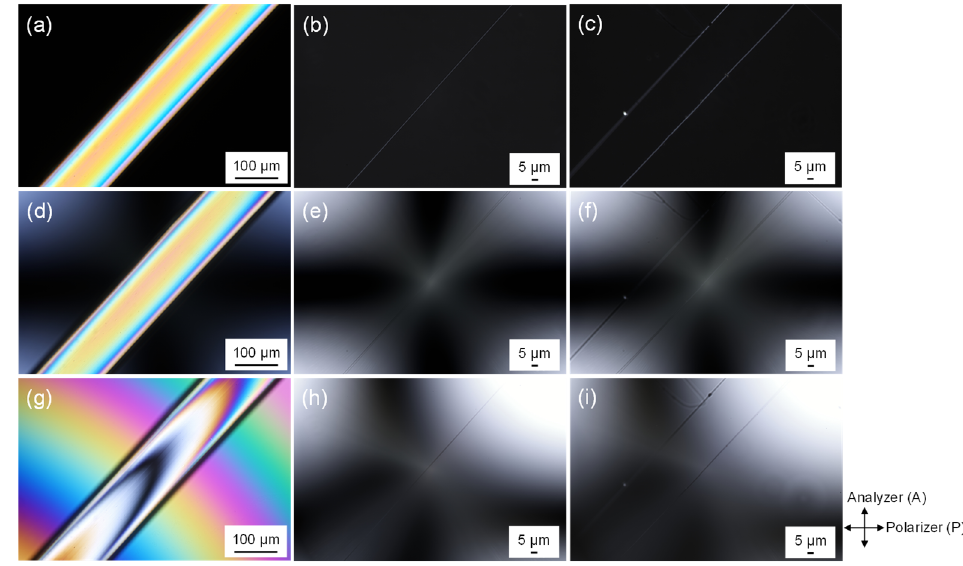
Figure 9. Images obtained under cross-polarization conditions for the ( a ) raw PLLA fiber, ( b ) electrospun PLLA web (14 W), and ( c ) electrospun BC/PLLA web (16 W); images acquired under cross-polarization conditions using the Bereck compensator without optical retardation for the ( d ) raw PLLA fiber, ( e ) electrospun PLLA web (14 W), and ( f ) electrospun BC/PLLA web (16 W); and images achieved under cross-polarization conditions with the Bereck compensator and optical retardation for the ( g ) raw PLLA fiber, ( h ) electrospun PLLA web (14 W), and ( i ) electrospun BC/PLLA web (16 W).